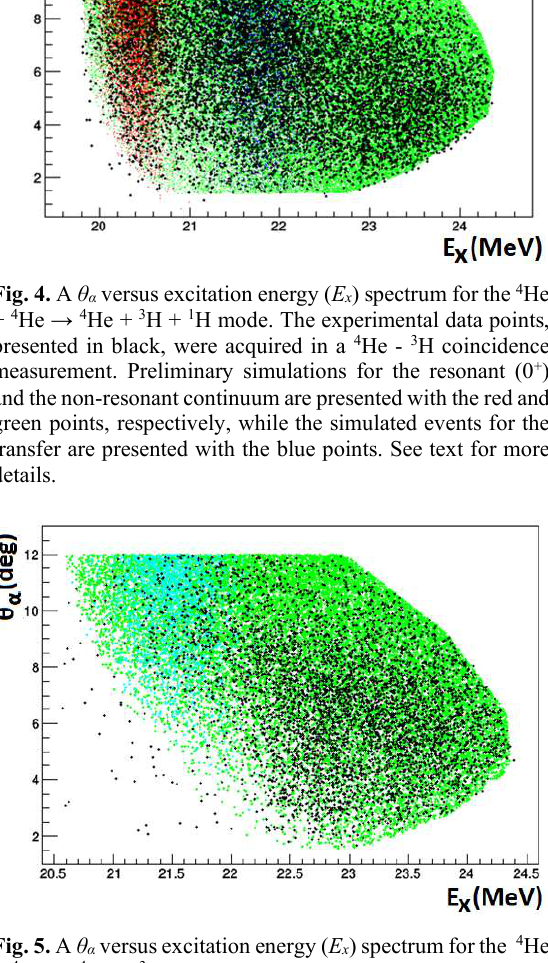
Fig. 5. A θ α versus excitation energy ( E x ) spectrum for the 4 He + 4 He → 4 He + 3 He + n mode. The experimental data points, presented in black, were acquired in a 4 He - 3 He coincidence measurement. Preliminary simulations for the non-resonant breakup and transfer are presented with the green and cyan blue points, respectively. See text for more